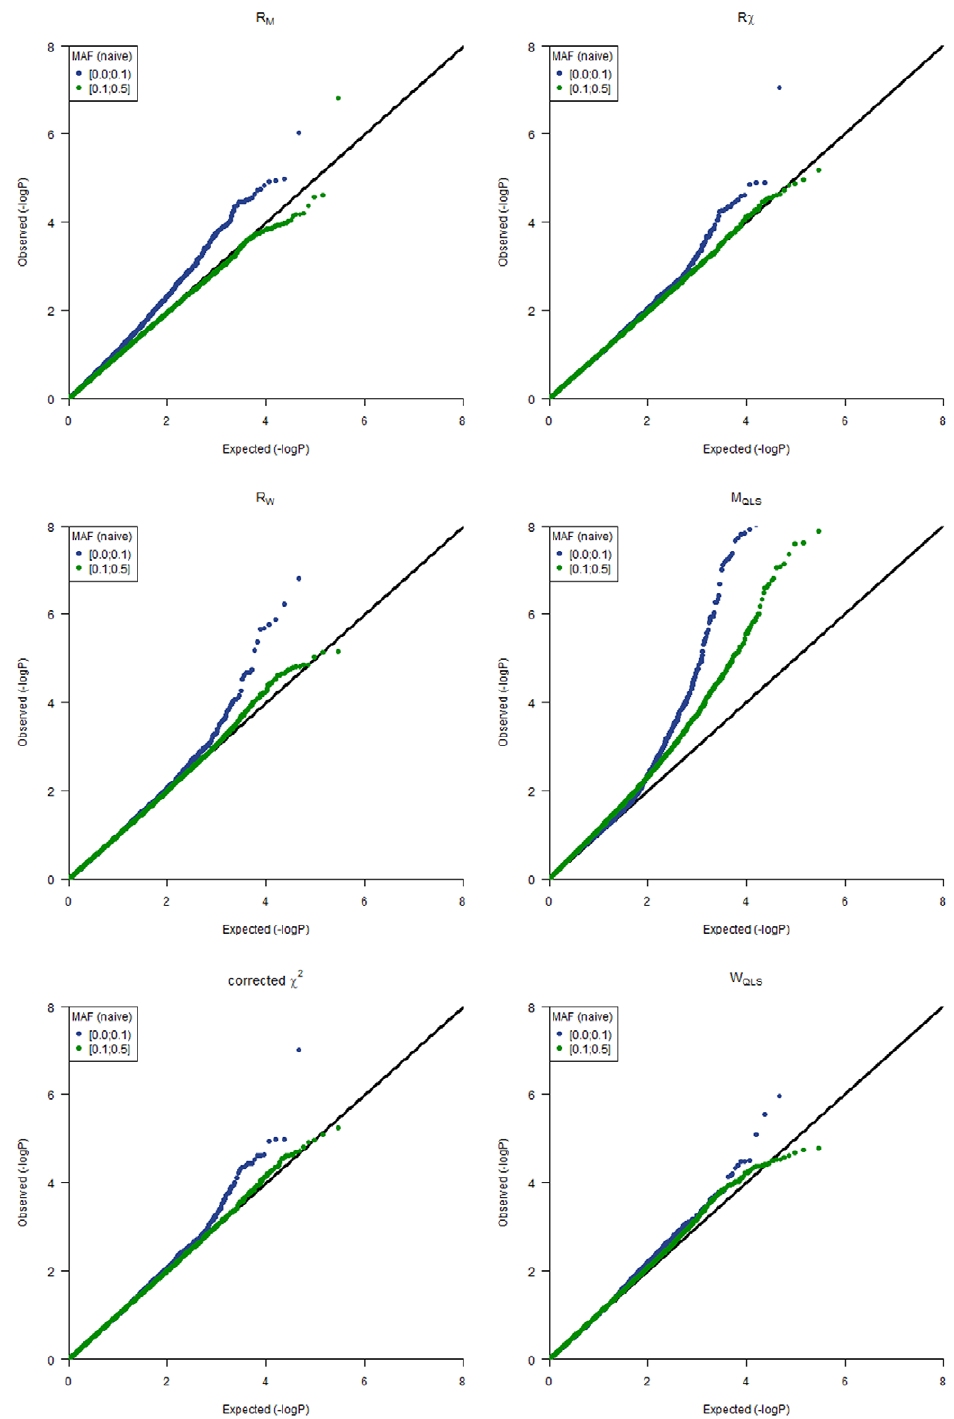
Figure 1. Q-Q plots for the different test statistics used in the analyses. Q-Q plots are stratified by the naı¨ve allele frequencies observed in the whole dataset. Namely, MAF . =0.1 (green points) or MAF , 0.1 (blue points).